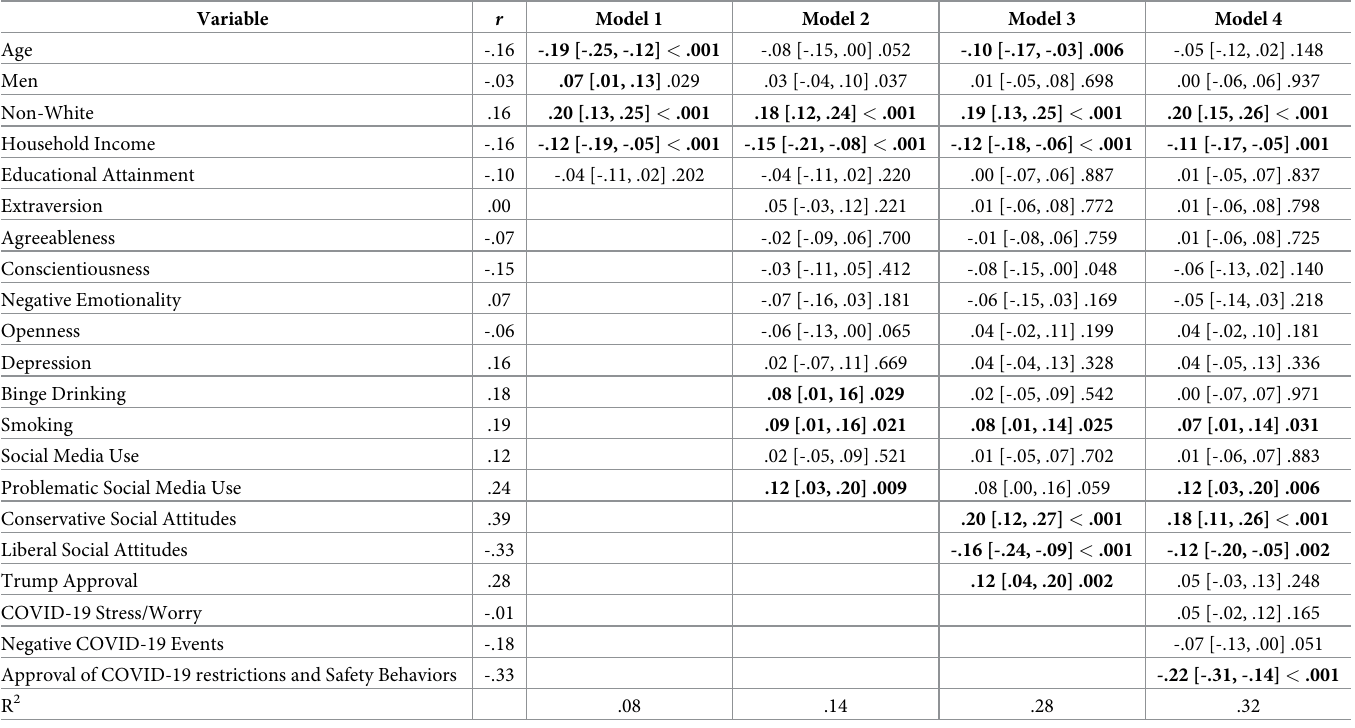
Table 7. Standardized regression coefficients from anti vax